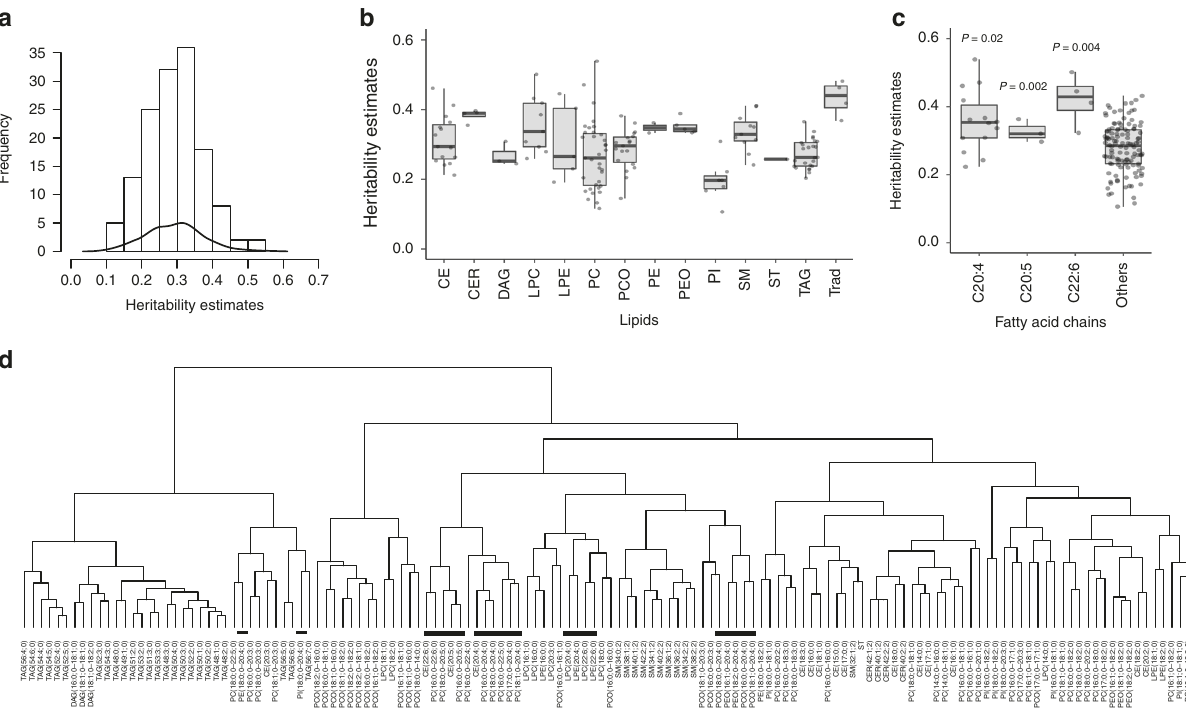
Fig. 2 Heritability of lipidomic pro fi les and genetic correlations among the lipid species. a Histogram and kernel density curve showing the distribution of heritability estimates across all the lipid species. b Boxplot showing the heritability estimates in each lipid class. c Boxplot showing comparison of the median heritability estimates of lipid species containing C20:4, C20:5 and C22:6 acyl chains and all others. The P- values were calculated using the Wilcoxon rank-sum test. d Hierarchical clustering of lipid species based on genetic correlations among lipid species. Lipids containing polyunsaturated fatty acids C20:5, C20:4 and C22:6 are highlighted with black bars. The data presented in the boxplots represent the interquartile range (IQR) de fi ned by the bounds of the box with the median (middle line of the box) and whiskers extending to the largest/smallest values no further than 1.5 times the IQR. CER ceramide, DAG diacylglyceride, LPC lysophosphatidylcholine, LPE lysophosphatidylethanolamine, PC phosphatidylcholine, PCO phosphatidylcholine- ether, PE phosphatidylethanolamine, PEO phosphatidylethanolamine-ether, PI phosphatidylinositol, CE cholesteryl ester, SM sphingomyelin, ST sterol, TAG triacyglycerol, Trad traditional lipids